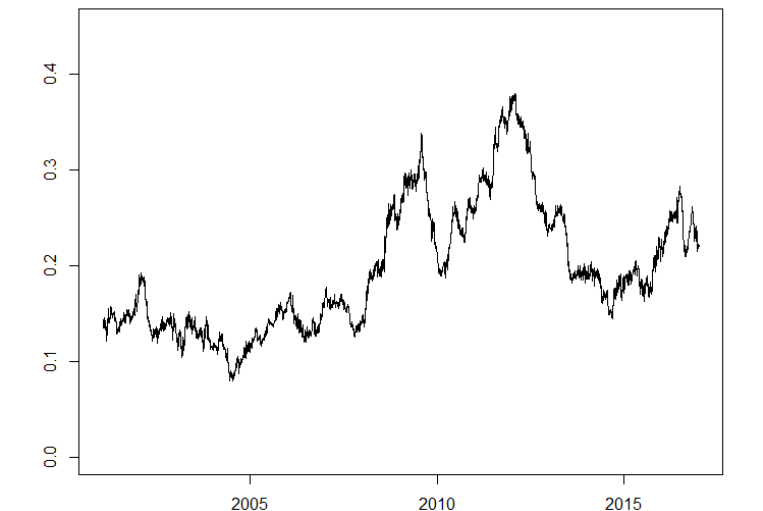
Figure 2: Dynamic total implied volatility spillover index for seven markets (the lasso